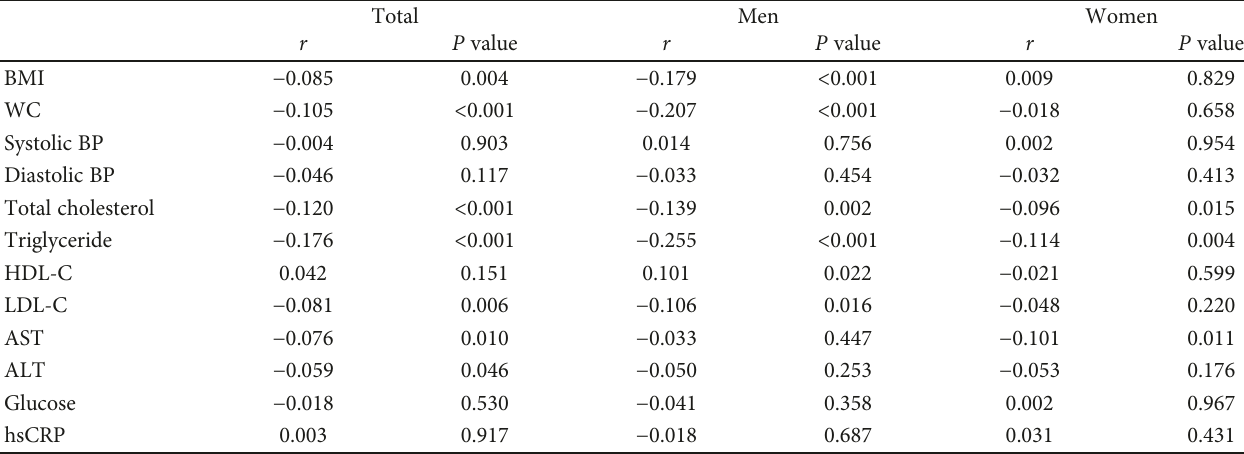
Table 2: Spearman partial correlations of cardiometabolic parameters with eGFR after adjusting for age and sex (total group) or age only (men and women).